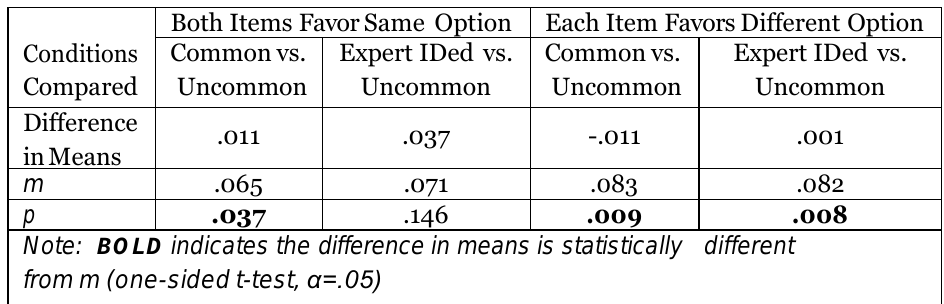
Table 3: Tests of Negligible Effect